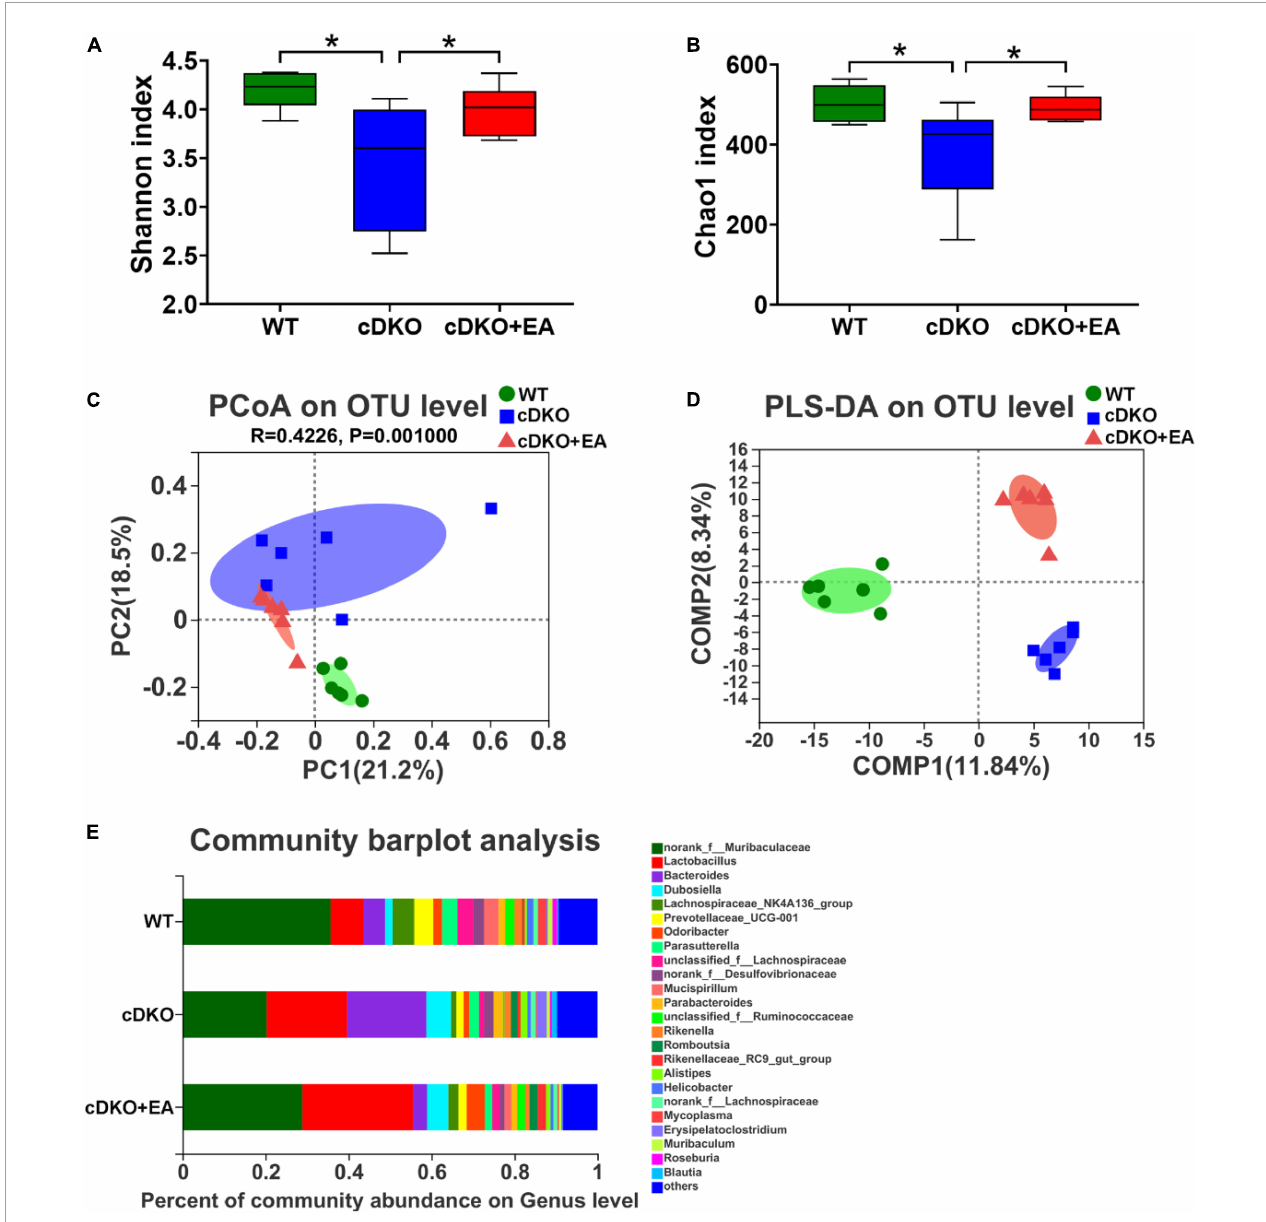
FIGURE5 Influence of electroacupuncture on gut taxa in PS cDKO mice. The α -diversity indexes of Shannon (A) and Chao1 (B) of gut microbiota. * P < 0.05. PCoA (C) and PLS-DA (D) of the gut microbiome composition of WT, cDKO, and cDKO + EA groups on the OUT level. (E) Relative abundance of the gut microbiome in the three groups, colored at and genus level, N =